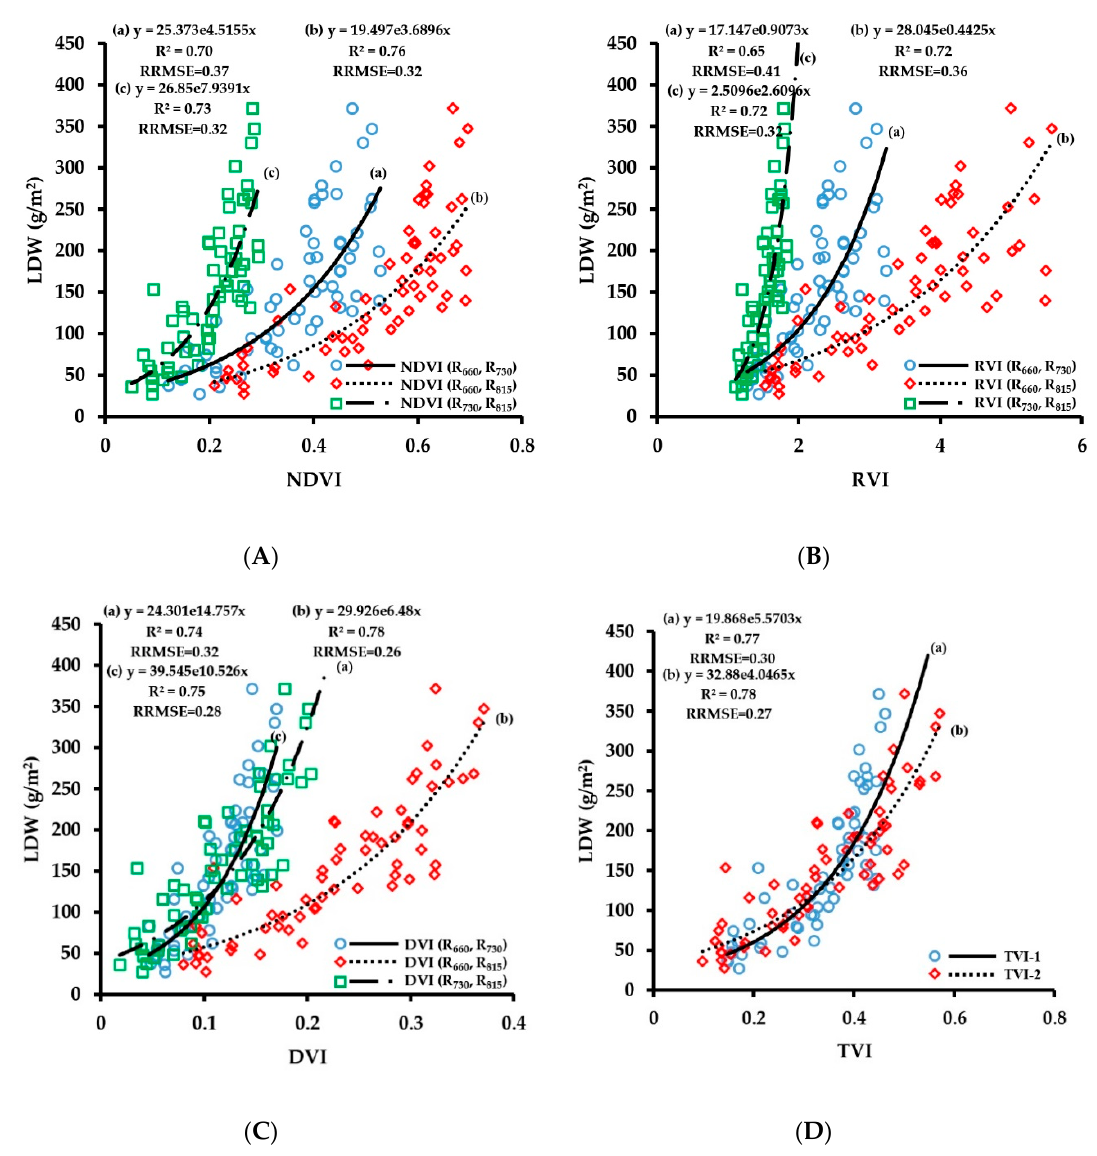
Figure 8. Fitting curve of NDVI ( A ), RVI ( B ), DVI ( C ) and TVI ( D ) to LDW of wheat.